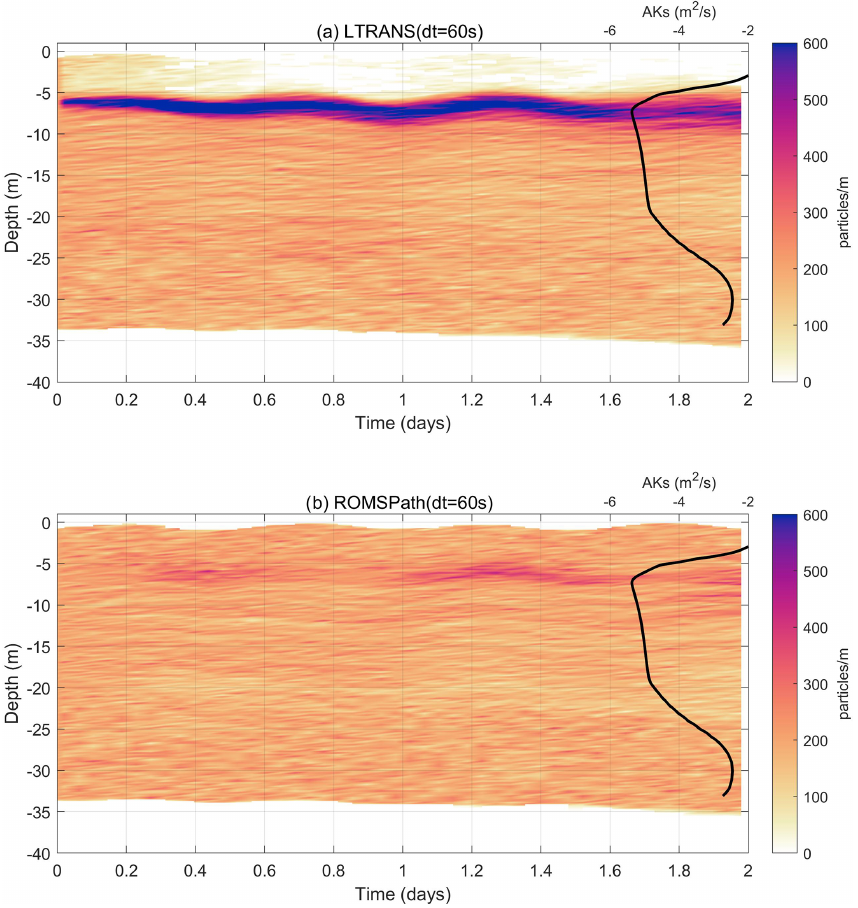
Figure 5. Vertical density of particles over time for the (a) LTRANS run (case D) and the ROMSPath run (case E). Both runs used a 60s time step and were initialized at the same horizontal location and time, with 3285 particles evenly. A representative vertical tracer diffusivity (log10(AKs)) is overlaid in black. The LTRANS run has particle clustering at the vertical diffusivity minimum due to a sign error in the vertical turbulence